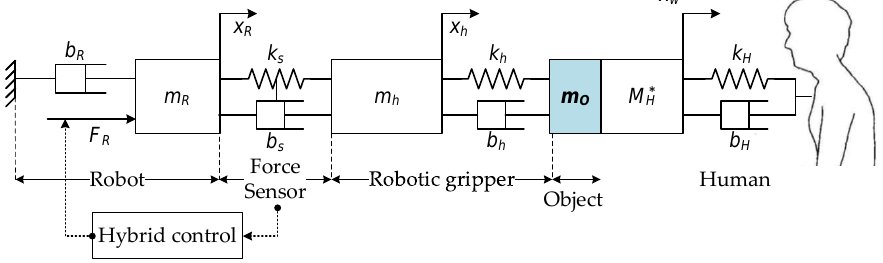
Figure 6. Mechanical schematic of the HRH based on a second-order-lumped-mass